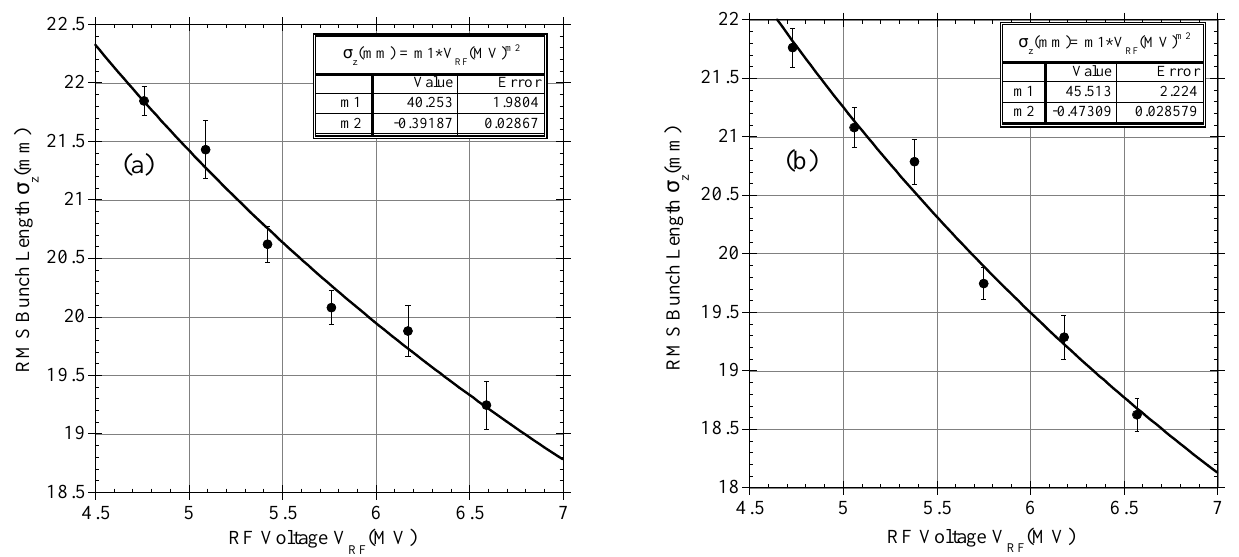
FIG. 8. The electron bunch length as a function of rf accelerating voltage with 18 bunches in the CESR ring at a current of (a) 9.0 mA per bunch and (b) 3.2 mA per bunch. 17.51818.51919.52020.521